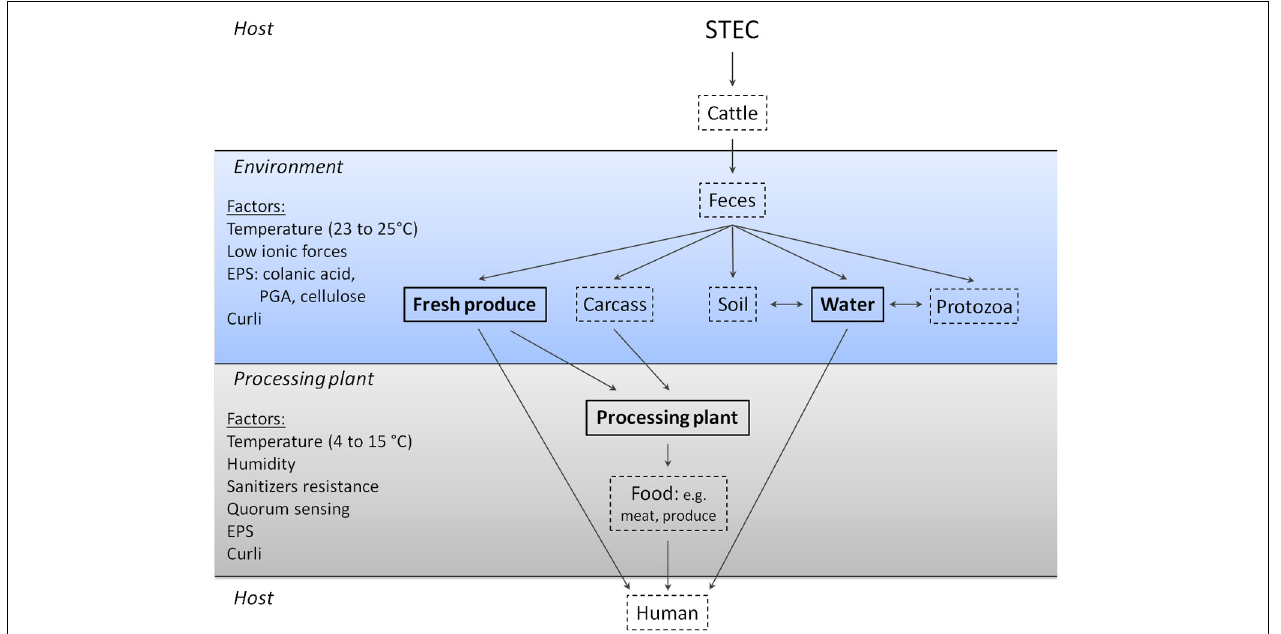
FIGURE 2 | Role of biofilm formation in the transmission and persistence of STEC outside of an animal host. Several studies demonstrated that STEC can persist as a biofilm on fresh produce, in water, and in processing plants. In some cases, factors contributing to biofilm formation have been identified. Texts in bold and framed by solid lines indicate environments where STEC biofilms are identified and participate in the persistence of